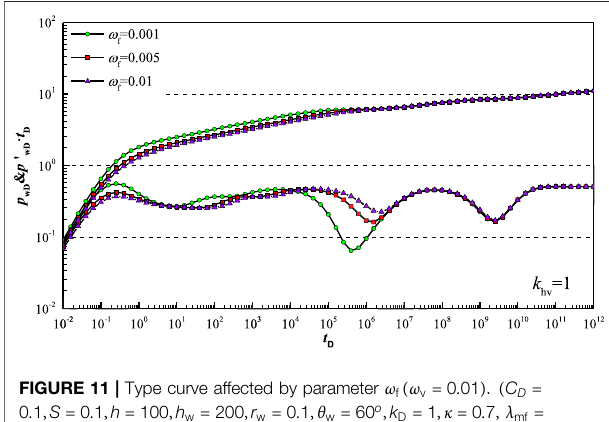
FIGURE 10 | Type curve affected by parameter ω v ( ω f (cid:2) 0 . 01 ) .